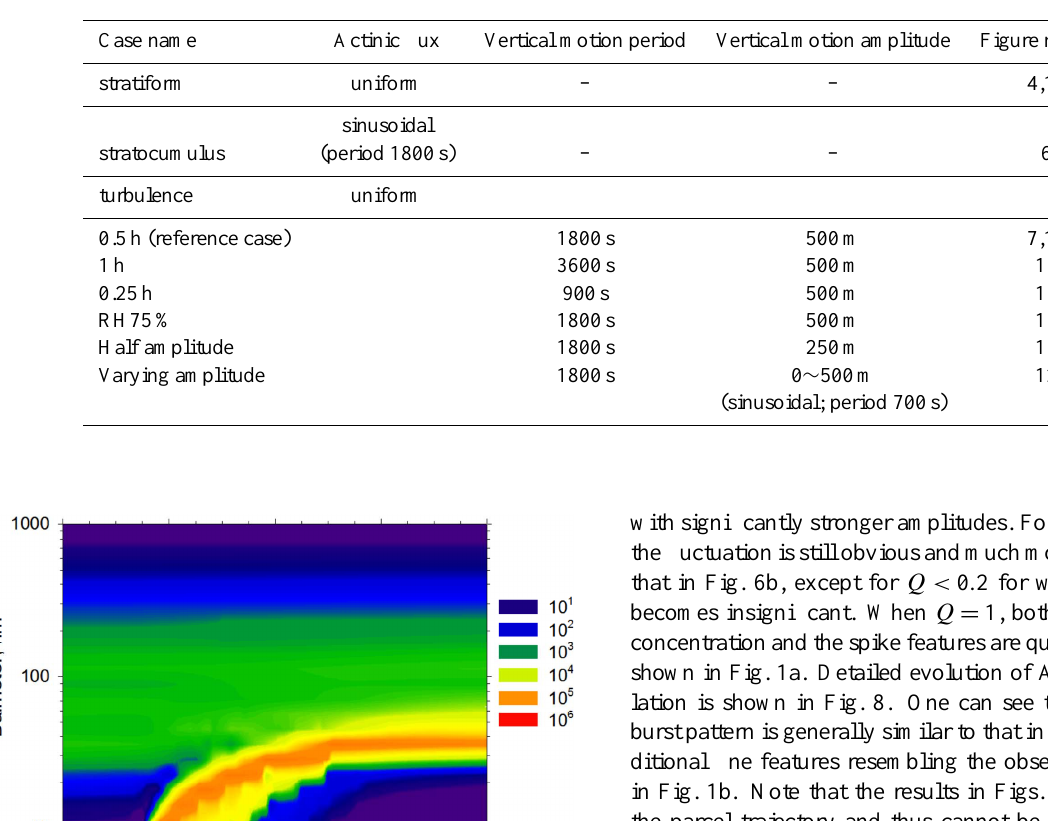
Table 1. Summary of the simulation cases and parameters used. All “turbulence” cases have a mid-level relative humidity of 80% except the one named RH75 used a value of 75%.